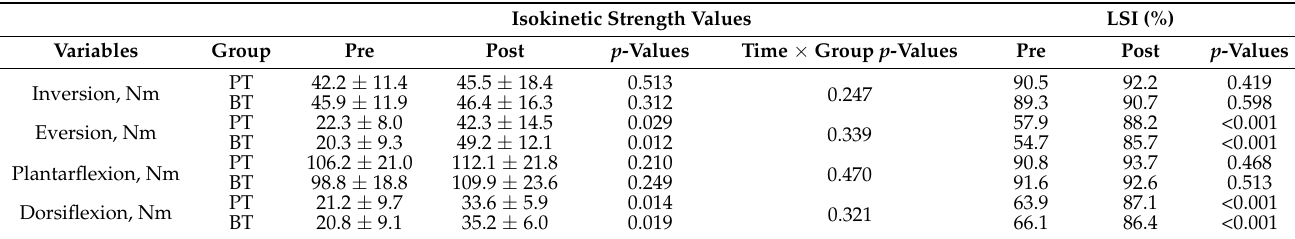
Table 3. Isokinetic ankle strength test (30 ◦